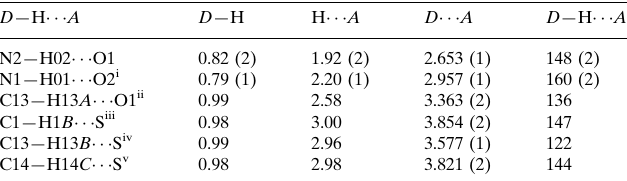
Hydrogen-bond geometry (A˚ , (cid:2)